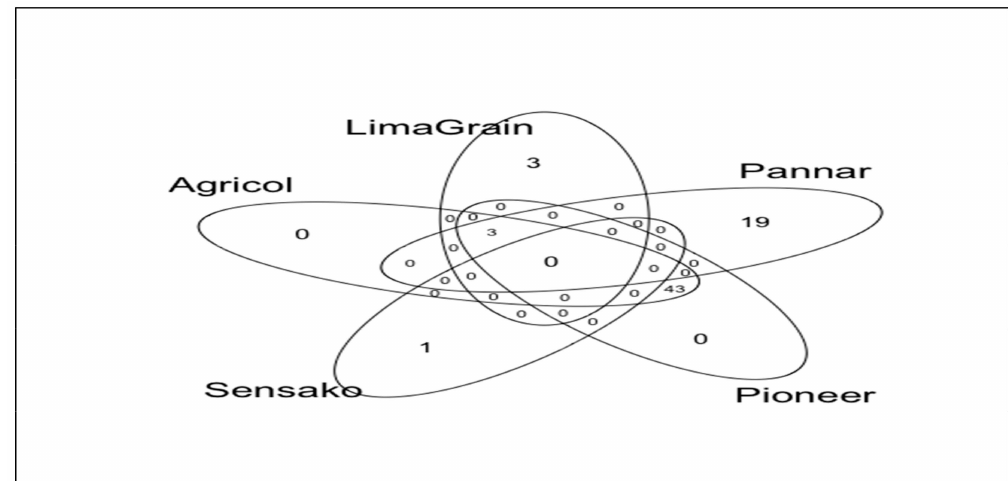
Figure 8. Venn diagram showing the shared and the unique ASVs of bacteria distribution among the various cultivar brands.